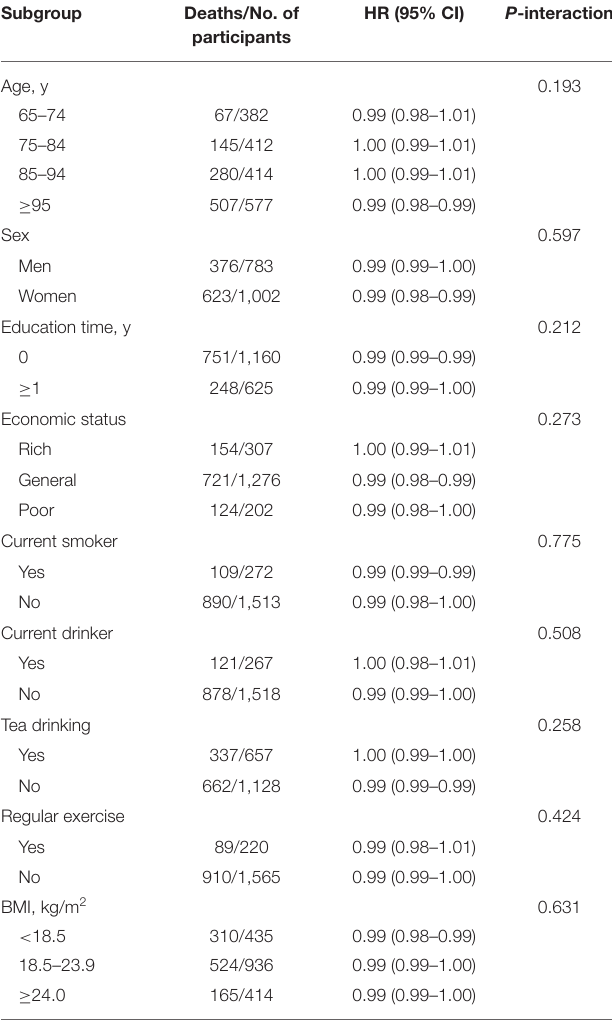
TABLE 4 | Subgroup analyses of the association between HB concentrations and all-cause mortality risk in the older adults form Chinese longevity regions. Subgroup